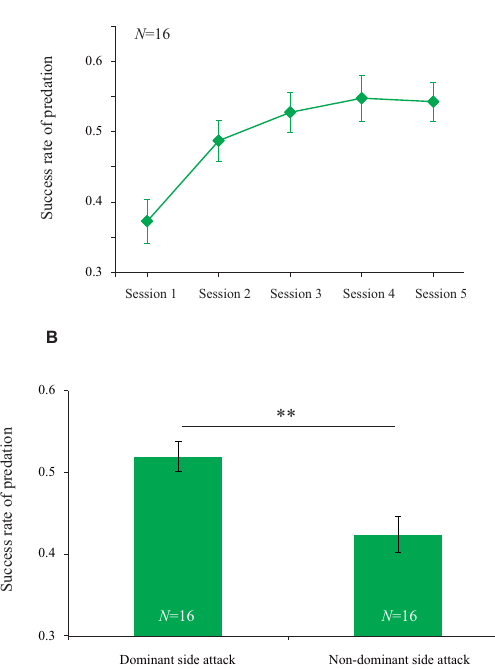
Figure 3. Success rate of predation. ( A ) The temporal change in the success rate of predation from Sessions 1 to 5 (mean ± SE, N = 16 fish). ( B ) The whole success rates of predation from dominant and non-dominant sides (mean ± SE, N = 16 fish). P-values are from GLMM analysis. ** P < 0.01.